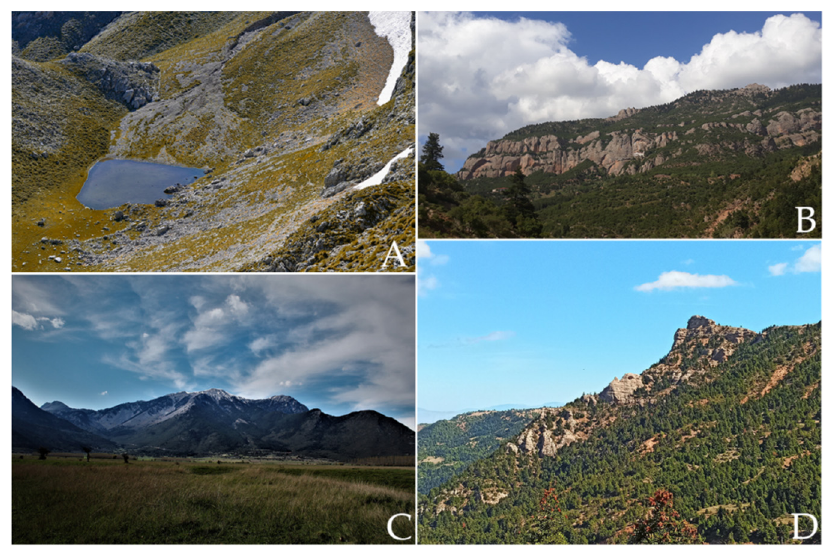
Figure 3. Representative views of the geosites described in the results. ( A ) Mavrolimni geosite 24, ( B ) Mega Spilaio, geosite 28, ( C ) Ntourntouvana, geosite 35, ( D ) Eroded conglomerates, geosite 38.